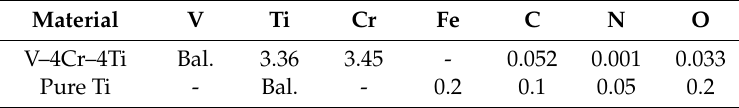
Table 1. Chemical composition of the parent materials (wt %).